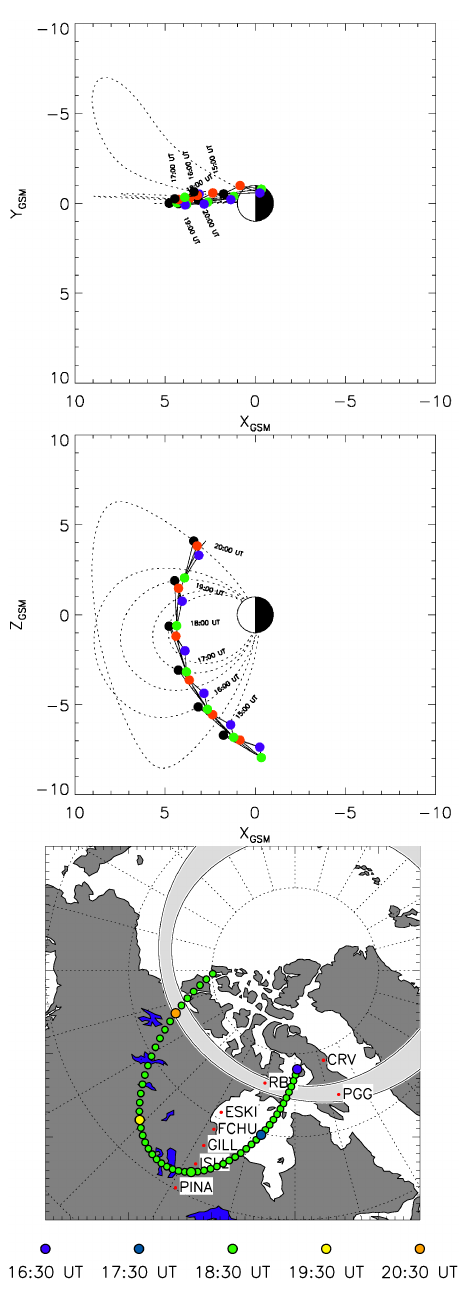
Fig. 3. The top two panels show the orbit of the Cluster satellites in GSM coordinates between 15:00 and 21:00UT projected into the XY and XZ plane. Every full hour the positions of all four spacecraft are shown, s/c 1 is coloured black, s/c 2 red, s/c 3 green and s/c 4 blue. The dotted lines indicate the magnetic field pre- dicted by the T96 model. The bottom panel shows the footprint of s/c 3 over Northern America in magnetic coordinates between 16:30 and 21:00UT. Positions of magnetometer stations belonging to the CARISMA and MACCS chain are also shown. The statisti- cal location of the auroral oval (Feldstein and Starkov, 1967) for the prevailing geomagnetic conditions ( K p =1) is superimposed in light grey for